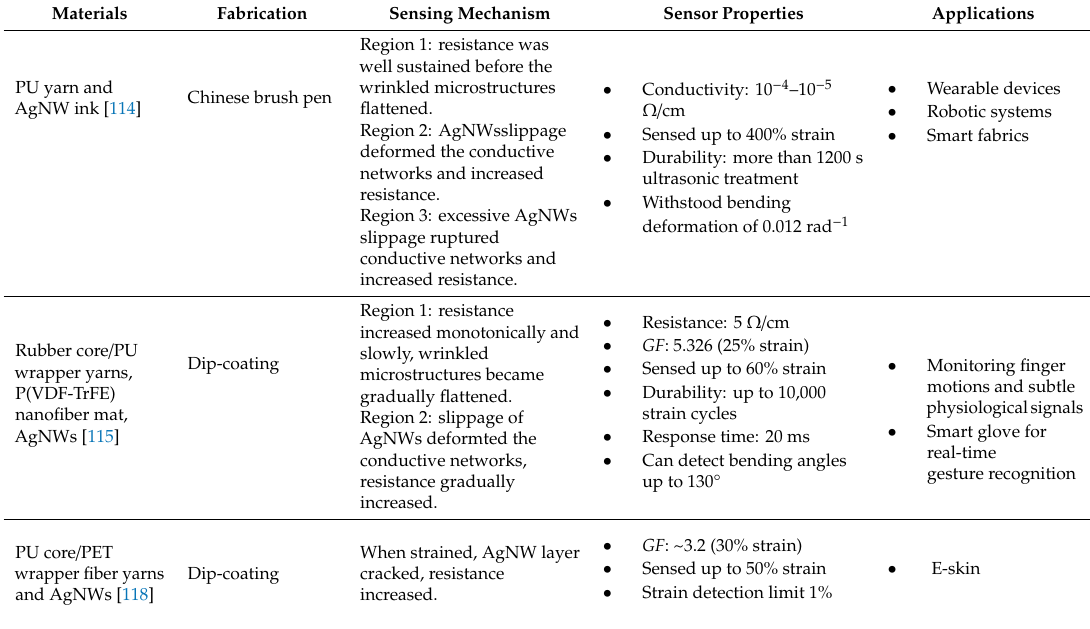
Table 5. Fiber-based strain sensors coated with